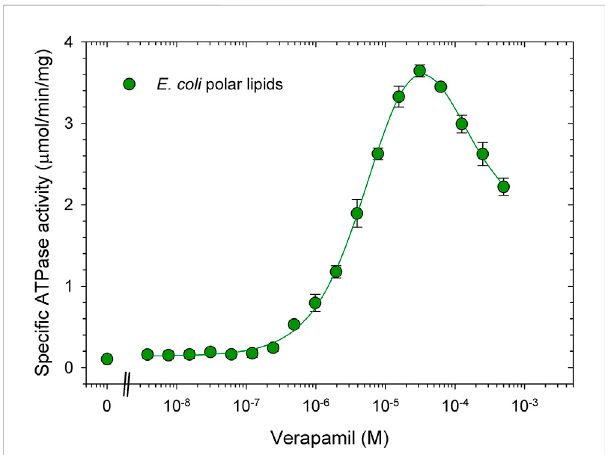
FIGURE 1 Verapamil-induced stimulation of ATPase activity in DDM- E. coli lipid mixed micelles. Puri fi ed Pgp in detergent solution was activated with 1% E. coli polar lipids and 10 mM DTT as described in experimental procedures. ATPase activity was measured in the presence of increasing concentrations of verapamil as indicated. Data points represent the mean ± SEM ( n = 3). Kinetic parameters obtained froma fi t(solidline)tothedatapointsislistedinTable2,fordetailssee